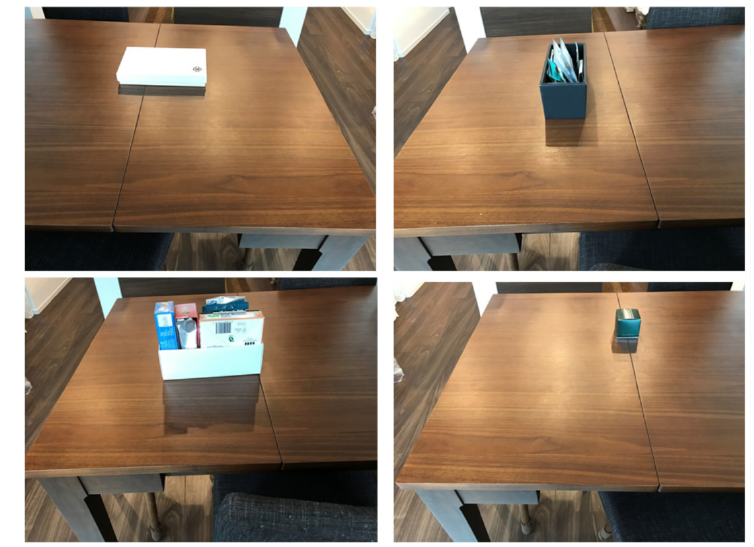
Figure 17. Different experimental